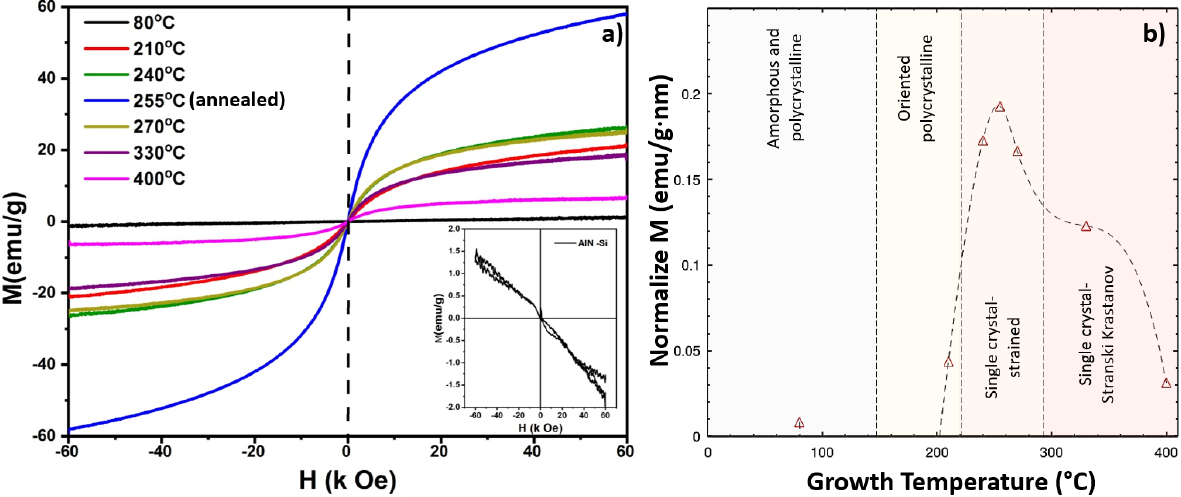
Figure 6. Room temperature VSM magnetization curves of samples grown at 80 °C, 210 °C, 240 °C, 255 °C, 270 °C, 330 °C and 400 °C ( a ) . Note that the 255 °C sample was annealed for 30 min at the growth temperature and was approximately double the thickness of the other samples. The inset image shows perfect diamagnetism of the AlN/Si substrate, which was measured in the same orientation as the Gd-containing films. Film thickness-normalized magnetization versus temperature plot with crystalline growth mode overlaid as advised by RHEED imaging is presented in ( b ).